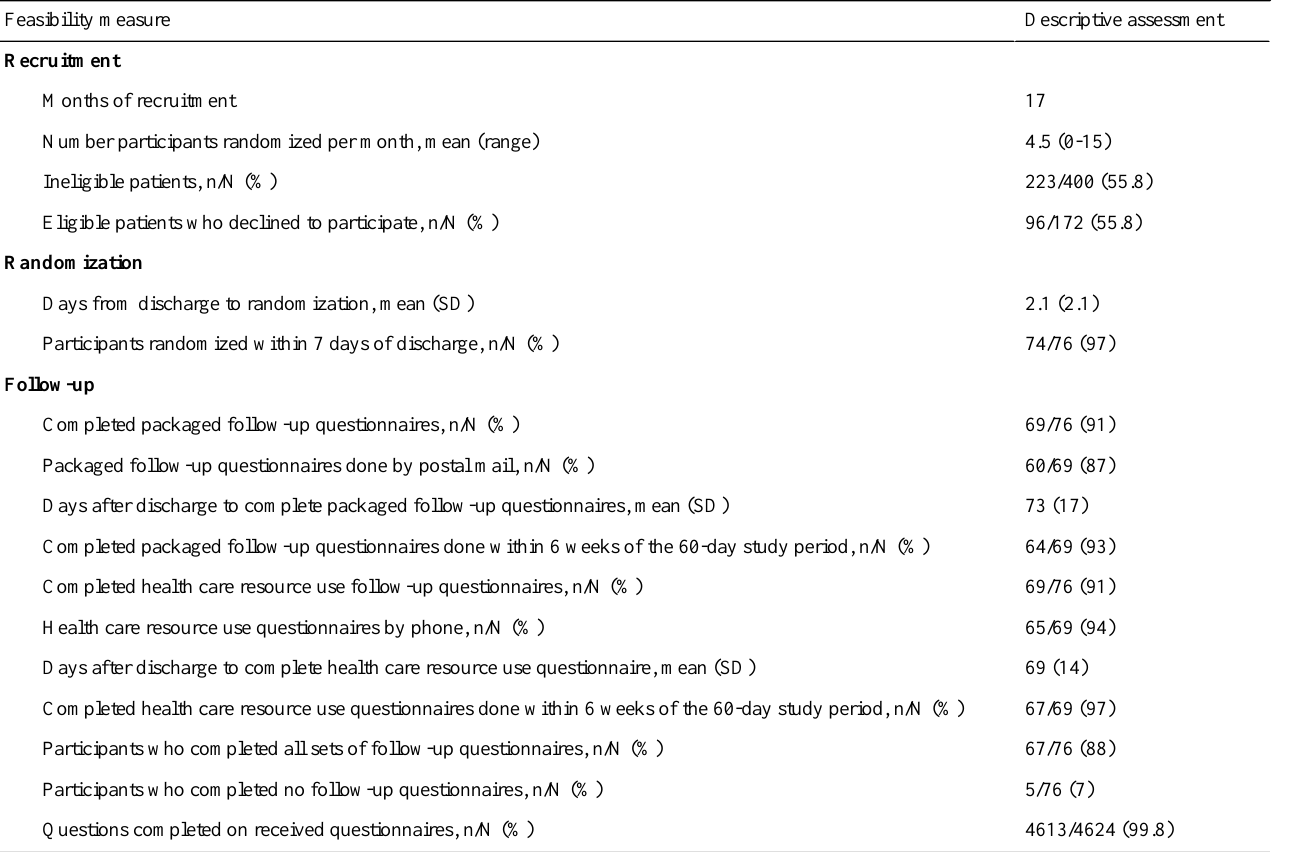
Table 7. Study protocol feasibility measures. a